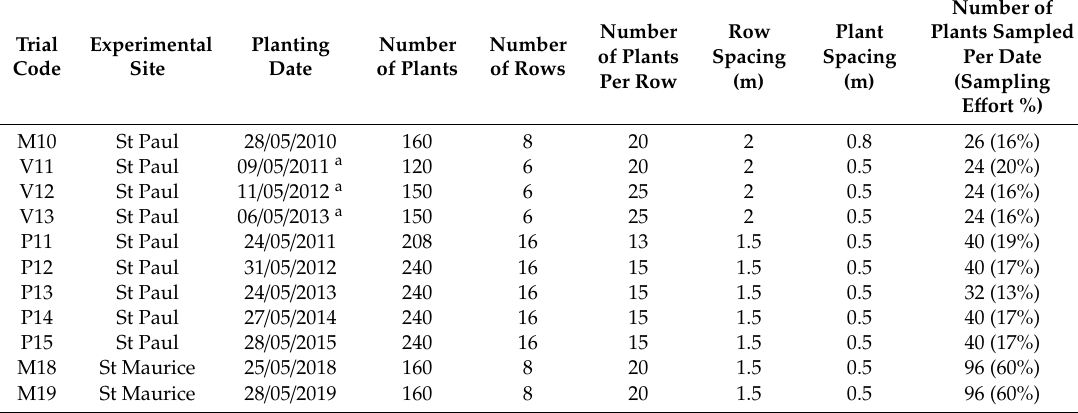
Table 1. Melon crop and sampling details for field trials conducted in Avignon between 2010 and 2019.